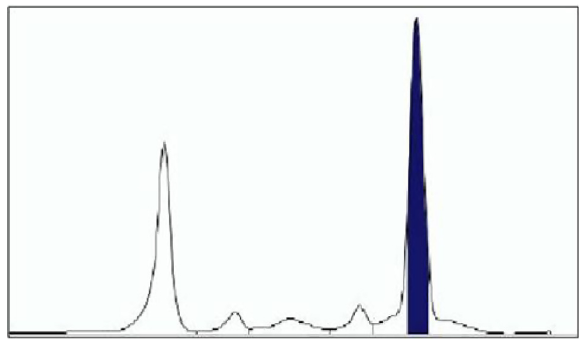
Serum electrophoresis showing a homogeneous nar- row peak and a dense band in the gamma